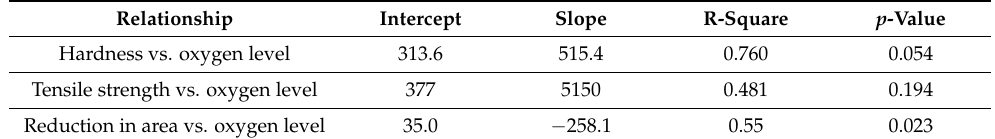
Table 4. Results of the regression analysis based on Tabor’s relationship and from [18] and [19].